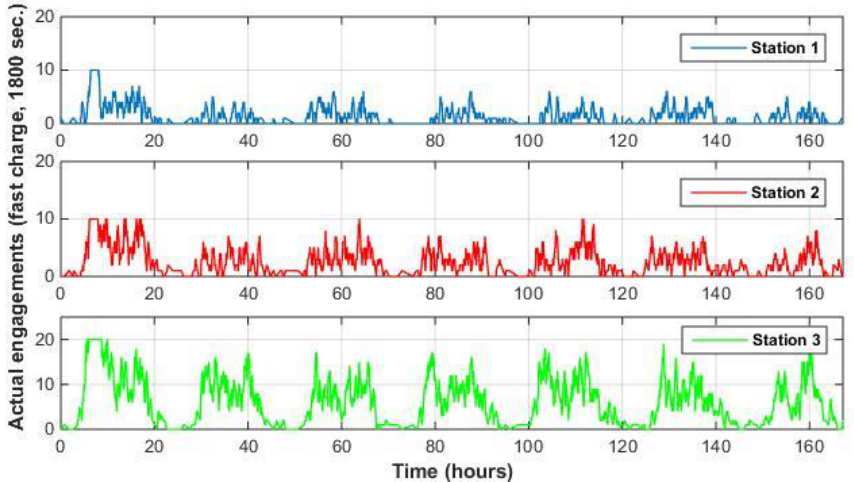
Figure 4. Engagement at the charging points (CPs) of each CI for (10 10 20) CP distribution. Different distributions of the CPs can change the LoS. For example, for the scenario (14, 12, 14) of CPs the LoS reduces to 87.6%. This represents a worsening compared to the (10, 10, 20) scenario